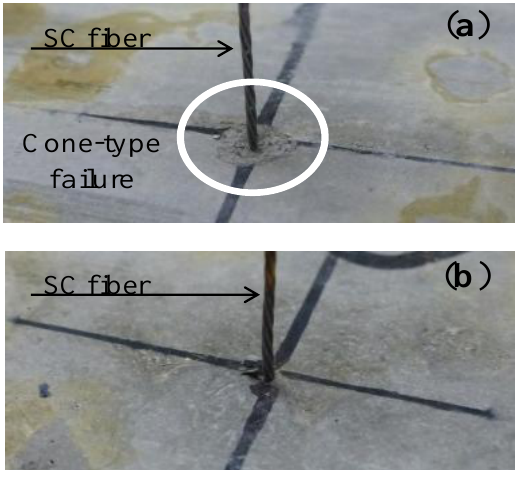
Figure 14. Matrix failure around fiber exit point: ( a ) PM and ( b )